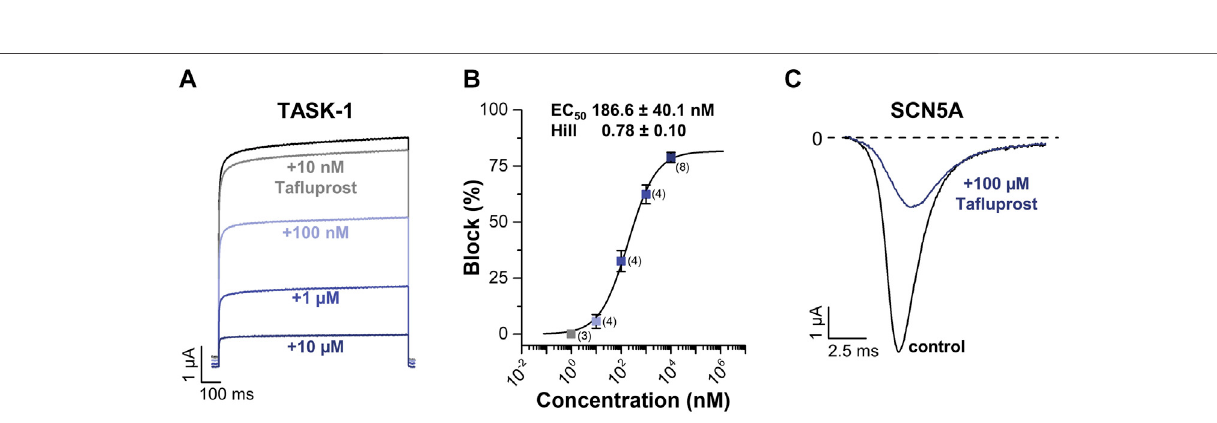
FIGURE 8 | Binding modes of ta fl uprost on TASK-1 (A) and NaV1.5 (B) . The box at (C) shows the estimation of Free Energy of Binding of bupivacaine and ta fl uprost for both proteins. These experiments were performed at the same conditions.